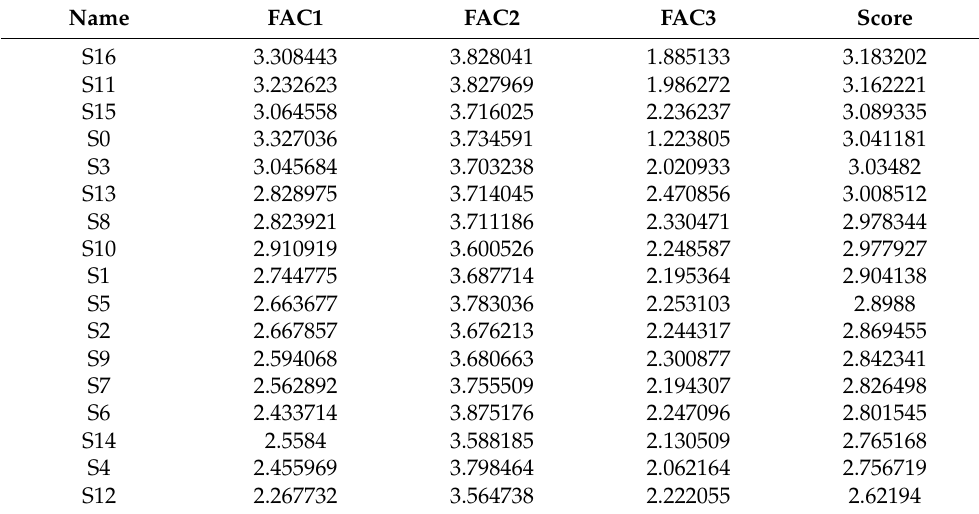
Table 9. Ranking of scene comprehensive